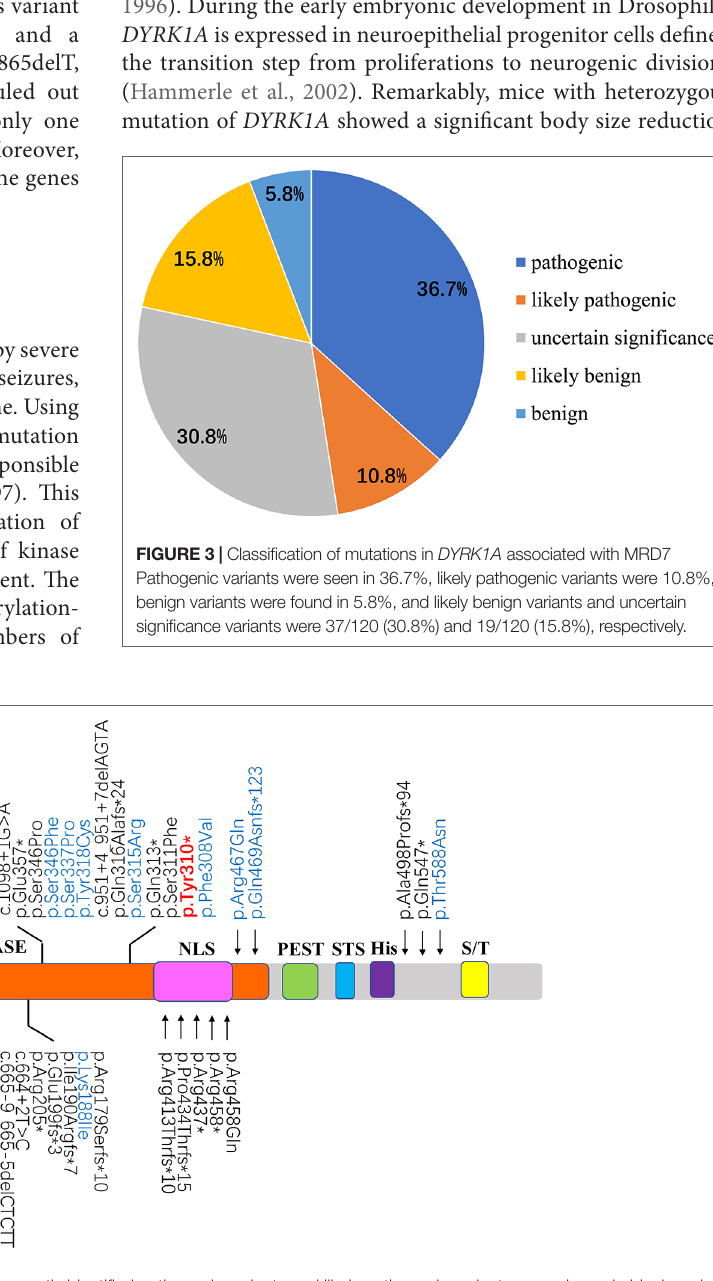
Frontiers in Genetics |